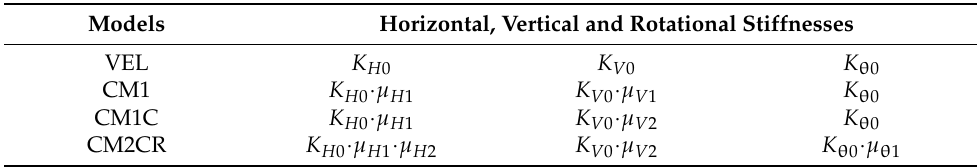
Table 1. Stiffnesses parameters of the elastomeric bearing in the different models.